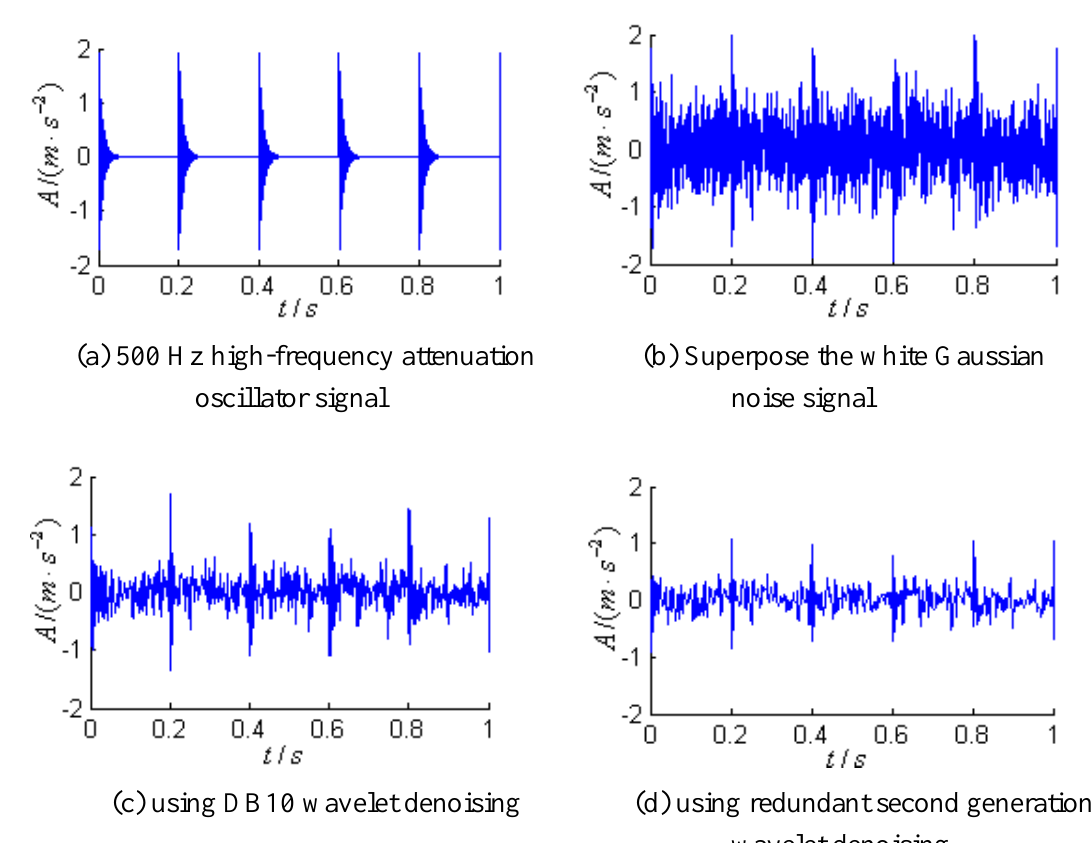
Figure 4. Comparison illustrations for signal